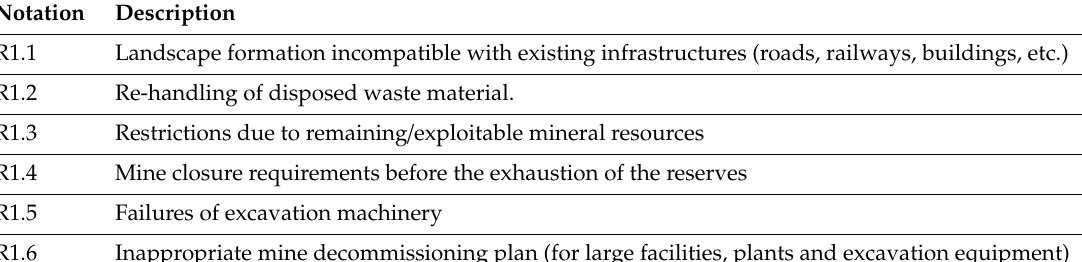
Table 1. Surface Lignite Mines Restoration Technical Risks